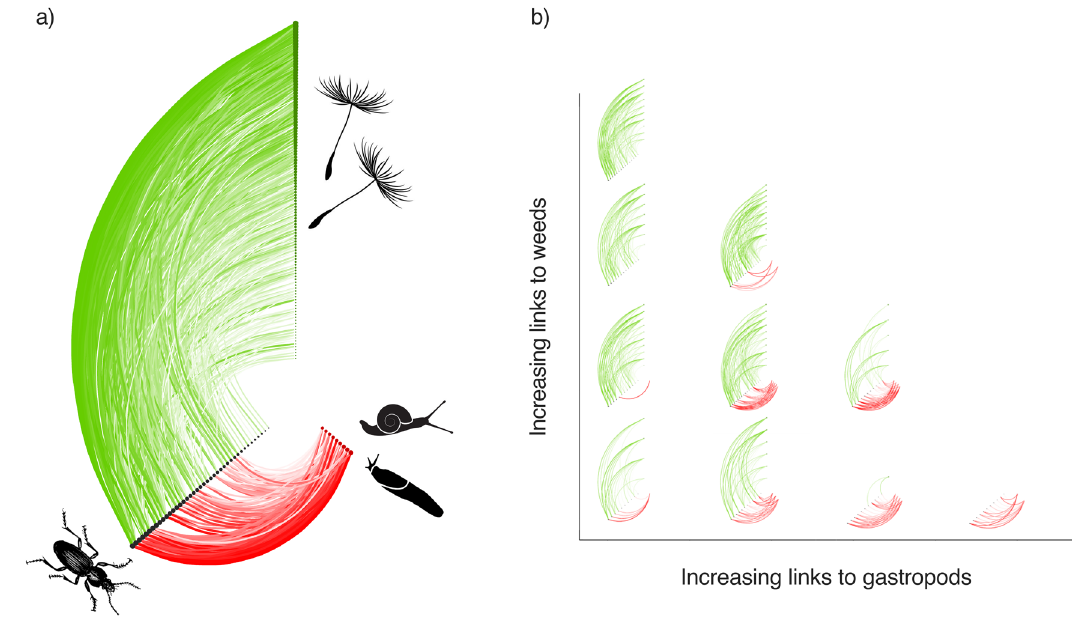
Fig. 1 Hive plots of carabid, weed and gastropod mollusc networks. a The ‘ composite network ’ encompassing all species and their interactions across all the multilayer networks from all sites used in this study. Carabid (black circles), weed (green circles) and gastropod mollusc (red circles) species nodes are sized proportionally to their rank of how often they were found across all networks. Link colour indicates the herbivore (green) and carnivore (red) layers, with the colour intensity and thickness being proportional to the strength of the interaction across all networks. b Example networks selected to show the trade-off between the number of links to the weeds and to the gastropods. The images of the beetle, weed seeds and molluscs are reproduced under the standard royalty free licence of 123rf.com (vectorgalaxy © 123RF.com; Patrick Guenette © 123RF.com; yod67 © 123RF.com; Autt Khamkhaunchan © 123RF.